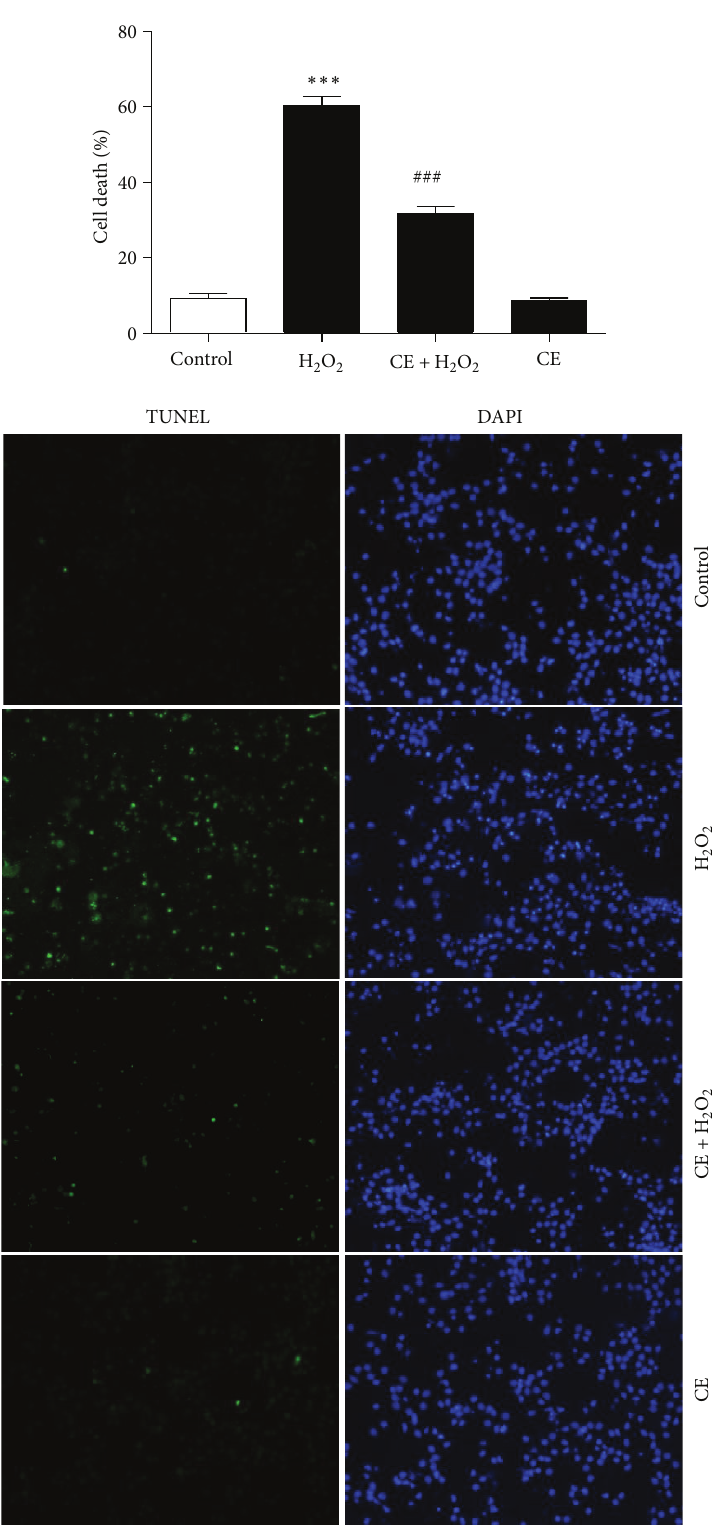
Figure 2: Photomicrographs and histograms showing that treatment with CE reduced H 2 O 2 induced cell death assessed by TUNEL assay. ∗ refers to a comparison of the control group and # refers to a comparison of the H